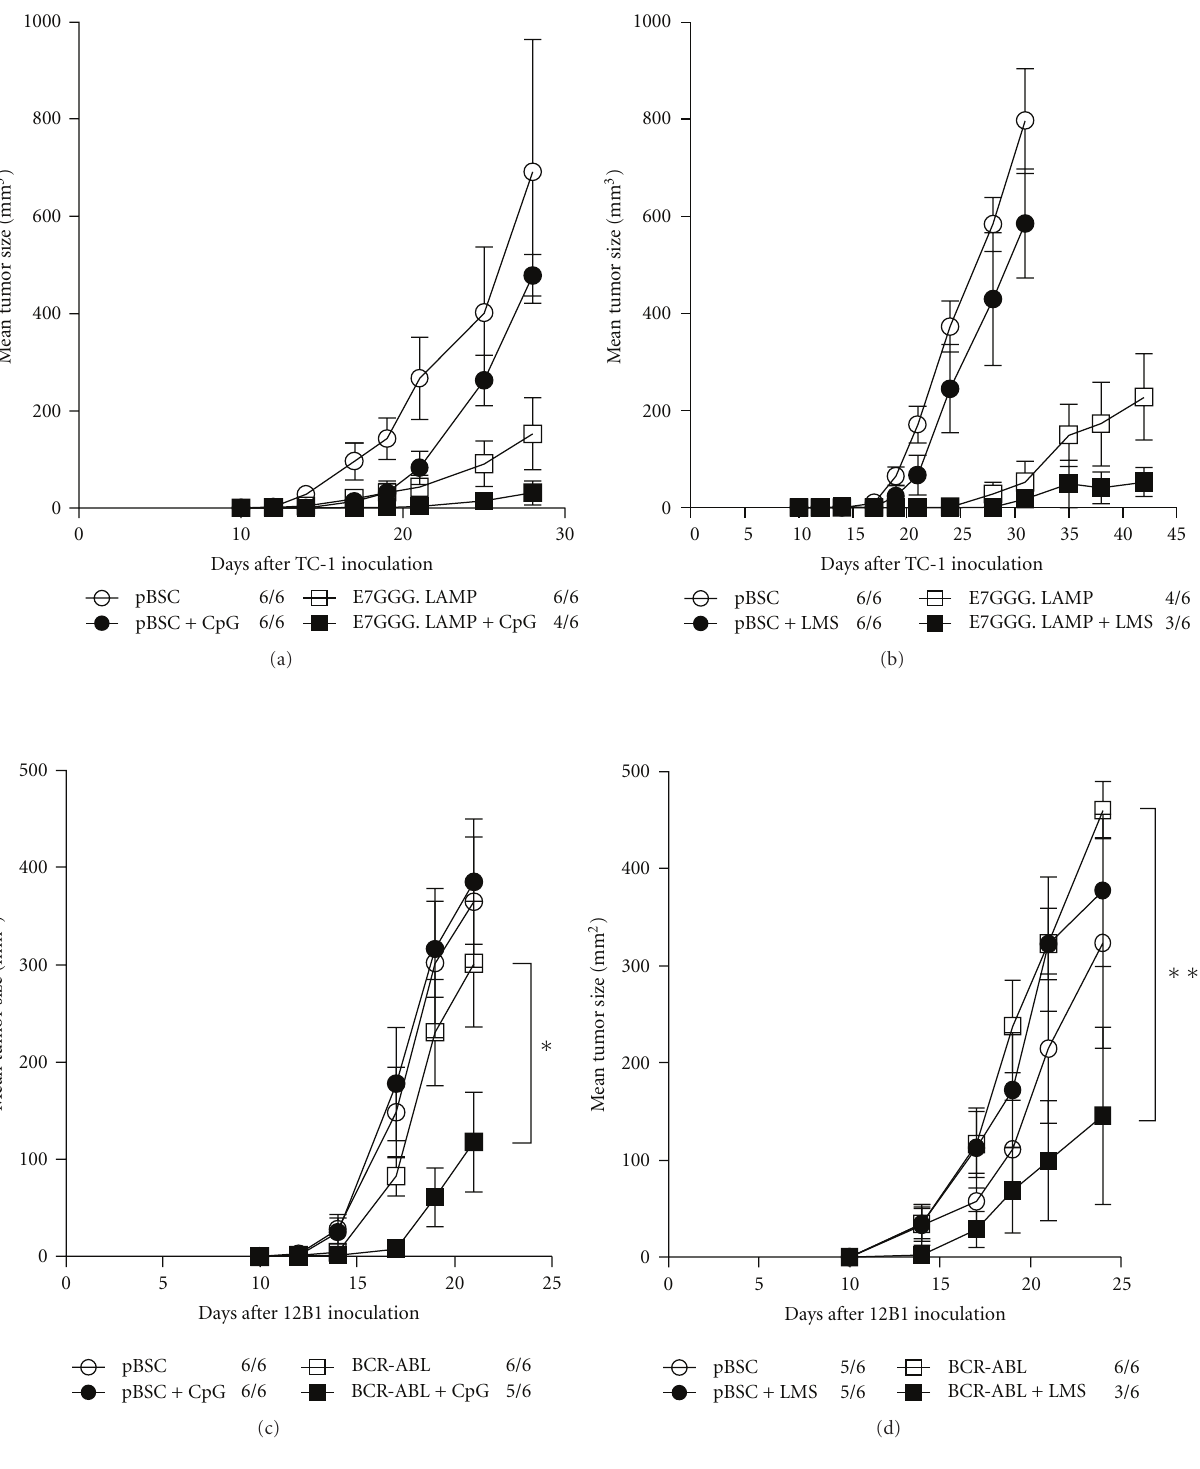
Figure 1: Antitumor e ff ect of systemic administration of high-dose adjuvants. C57BL/6 or BALB/c mice ( n = 6) were s.c. inoculated with 3 × 10 4 TC-1 (a, b) or 5 × 10 3 12B1 cells (c, d) and immunized by a gene gun with 1 μ g of pBSC/E7GGG.LAMP three and ten days later or with 2 μ g of pBSC/bcr-abl three, six, and ten days later, respectively. The pBSC plasmid was used as a negative control. CpG-ODN (50 μ g; a, c) or LMS (200 μ g; b, d) was i.p. injected on the days of DNA vaccination. No. of mice with a tumor/no. of mice in the group is indicated. Bars: ± SD; ∗ P < 0 . 05; ∗∗ P < 0 .